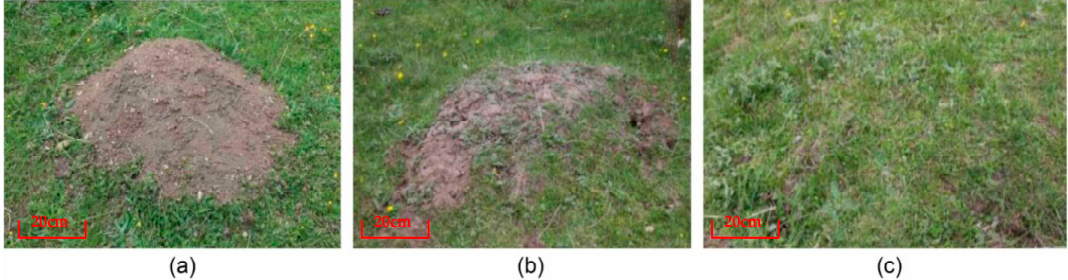
Figure 2. Sampling sites of ( a ) zokor mound; ( b ) vegetation-recovered site; and ( c ) healthy meadow. Sampling plots have a size of 2 m by 2 m, centred around the mound.